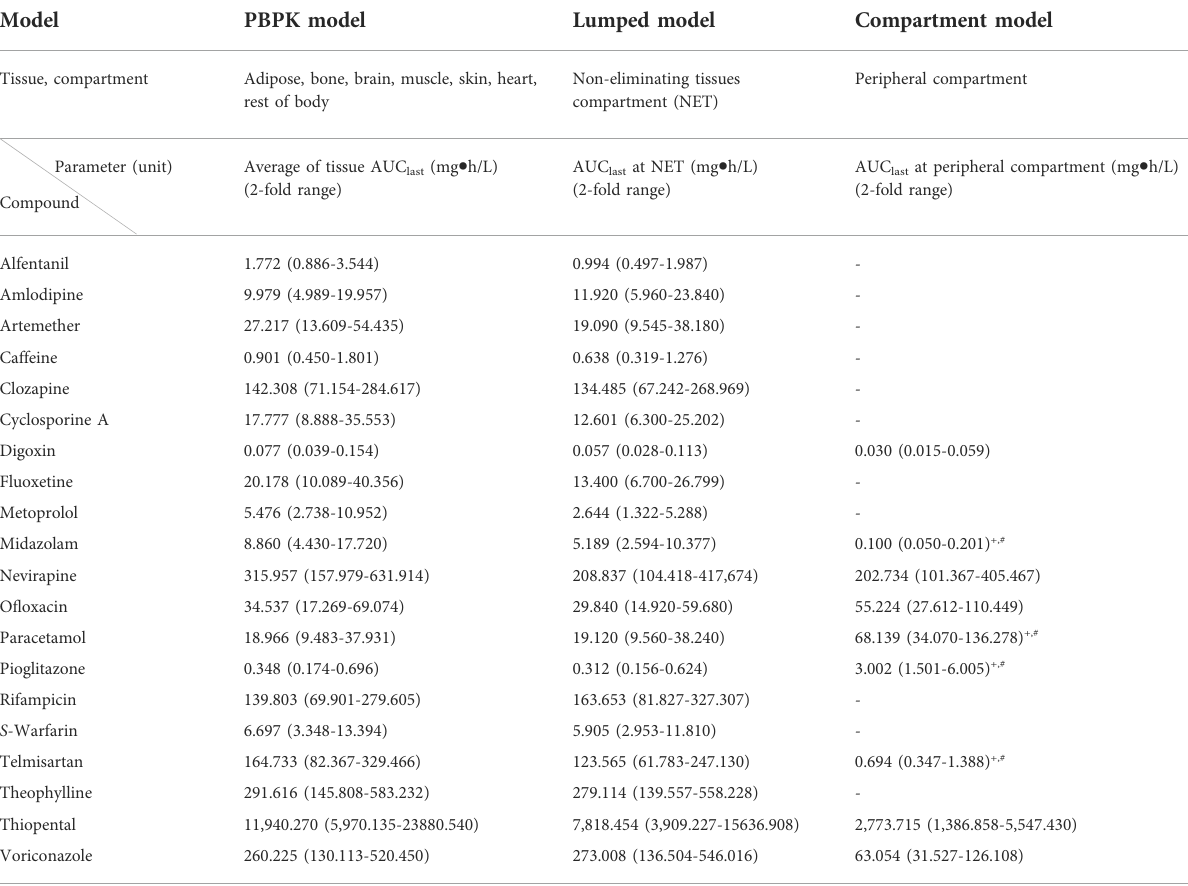
TABLE 2 Comparison of AUC parameters of peripheral compartment in PBPK, lumped, and compartment models for 20